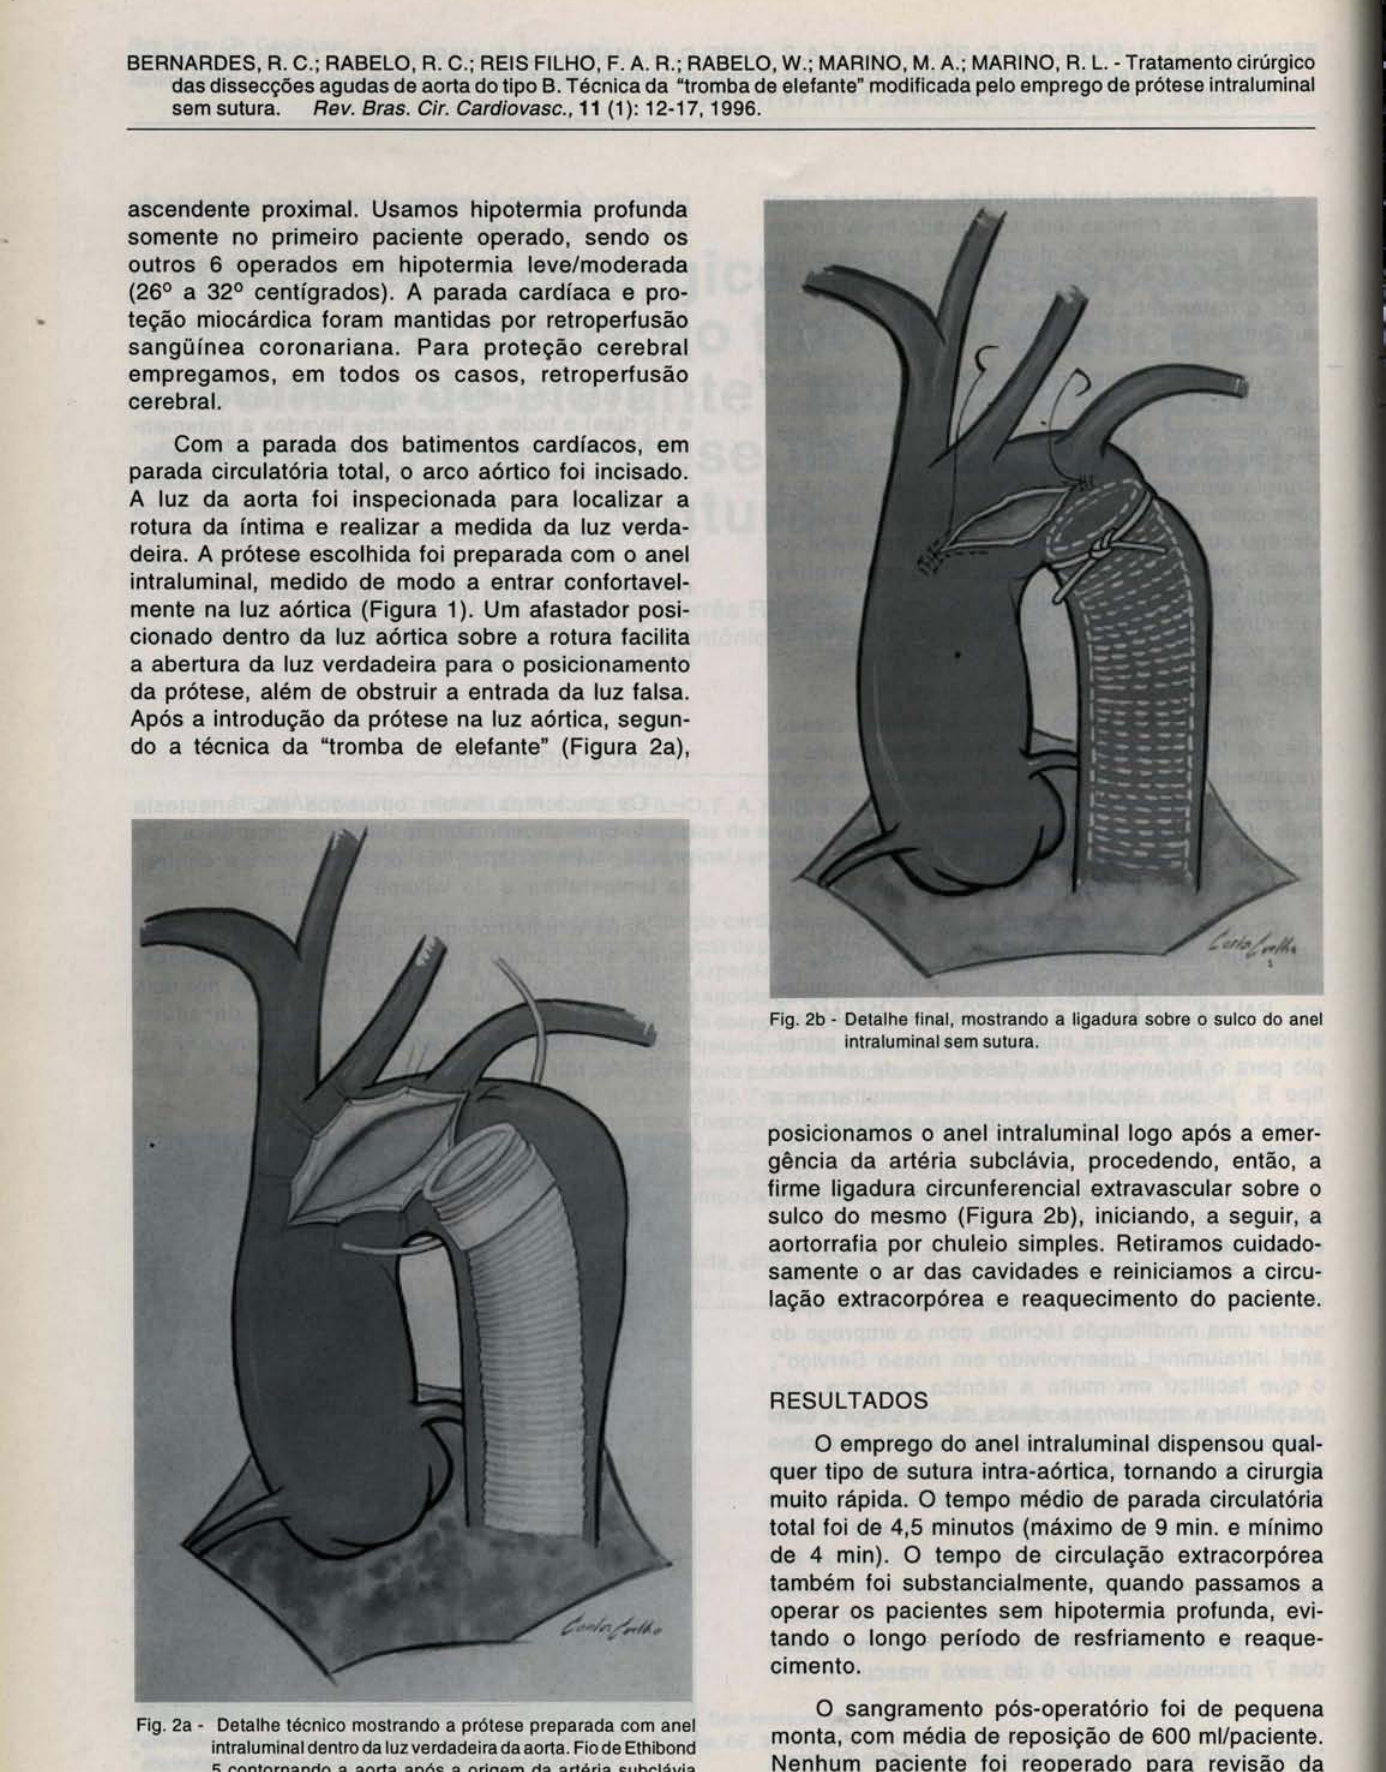
Fig. 2b - Detalhe final, mostrando a ligadura sobre o sulco do anel intraluminal sem